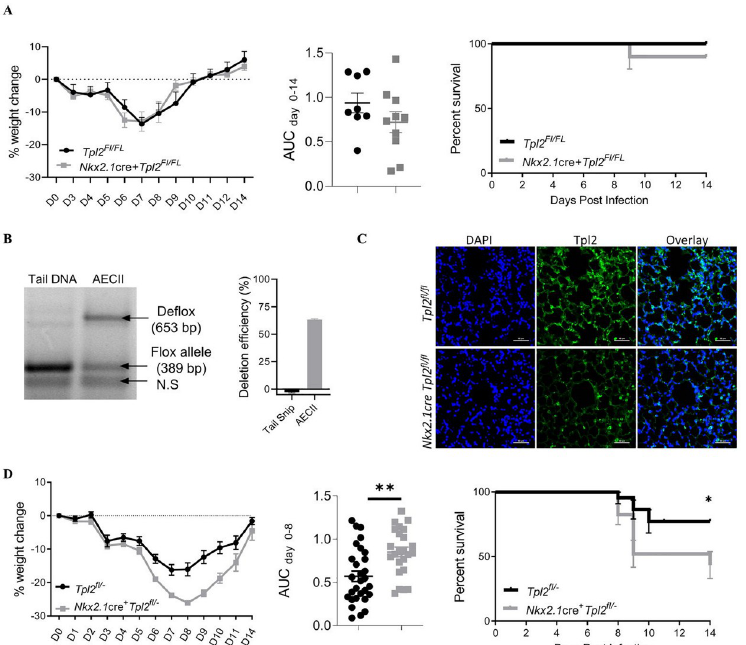
Fig 2. Contribution of Tpl2 expression within pulmonary epithelial cells to morbidity and mortality during influenza infection. (A) Tpl2 fl/fl and Nkx2 . 1cre + Tpl2 fl/fl conditional knockout mice were infected intranasally with 10 4 PFU influenza A/x31. Morbidity (left panel) was assessed by daily weight loss. Significance of weight loss was determined by area under the curve (AUC) analysis with an unpaired two-tailed T-test (middle panel). Survival curve (right panel) of the same Tpl2 fl/fl and Nkx2.1cre + Tpl2 fl/fl conditional knockout mice after IAV infection. Mean survival = 100% for Tpl2 fl/fl and 90% for Nkx2 . 1cre + Tpl2 fl/fl ; Log-rank (Mantel-Cox) test. Cre - N = 8, Cre + N = 10. Data representative of 2 experiments. Error bars represent means ± SEM. (B) Representative image from 3 mice in which tail snip DNA and DNA from isolated AECII were subjected to genomic amplification of the defloxed allele versus the intact floxed allele. By comparison, Tpl2 was undeleted in tail DNA where Nkx2.1-cre expression is absent. Quantification of deletion efficiency in Nkx2 . 1cre + Tpl2 fl/fl mice is shown to the right. N = 3 mice. (C) Immunofluorescence staining of Tpl2 in lungs of Nkx2 . 1cre + Tpl2 fl/fl and Tpl2 fl/fl mice as in Fig 1A. (D) Tpl2 fl- and Nkx2 . 1cre + Tpl2 fl- conditional knockout mice were infected intranasally with 10 4 PFU influenza A/x31. Morbidity was assessed by daily weight loss (left panel). Significance of weight loss was determined by area under the curve (AUC) analysis with an unpaired two-tailed t-test (middle panel). Cre- N = 29, cre+ N = 24. Pooled data from 3 experiments. Survival curve (Right panel) of Tpl2 fl/- and Nkx2 . 1cre + Tpl2 fl/- conditional knockout mice after IAV infection. � p - value = 0.0199. Mean survival = 77.2% for Tpl2 fl/- and 43.3% for Nkx2 . 1cre + Tpl2 fl/- ; Log-rank (Mantel-Cox) test. Cre- N = 22, cre+ N = 23. Pooled data from 3 experiments; Error bars represent means ± SEM. � p < 0.05, �� p < 0.005. Multiple lines of evidence have recently implicated Tpl2 in restraining fibrotic responses, both in intestinal myofibroblast-mediated fibrosis in the gut [23] and in bleomycin-induce lung fibrosis [22]. Because pulmonary fibrosis can impair lung function during influenza infection [40], we assessed whether Tpl2 protects against influenza-induced lung injury by inhibiting pulmonary fibrosis. However, no significant differences in pulmonary fibrosis were noted in the major regions of the lung (Fig 4B and 4C). Consistently, lung collagen levels, as determined by hydroxyproline assay at 8 dpi, showed no significant difference between strains (S1A Fig), nor were there any differences in key lung fibrotic markers, Ptges2 , Reg3g , and Timp1 at 8.5 dpi (S1B Fig). To determine if Tpl2 ablation in non-hematopoietic cells indirectly caused systemic hematologic or metabolic effects that could be responsible for increased mor- bidity and mortality, we examined several clinical markers of systemic disease at the peak of morbidity (8.5 dpi) in one large representative cohort of mice. The circulating number and fre- quency of immune cells was not different compared to Tpl2 fl/- mice (S2 Fig). Additionally,